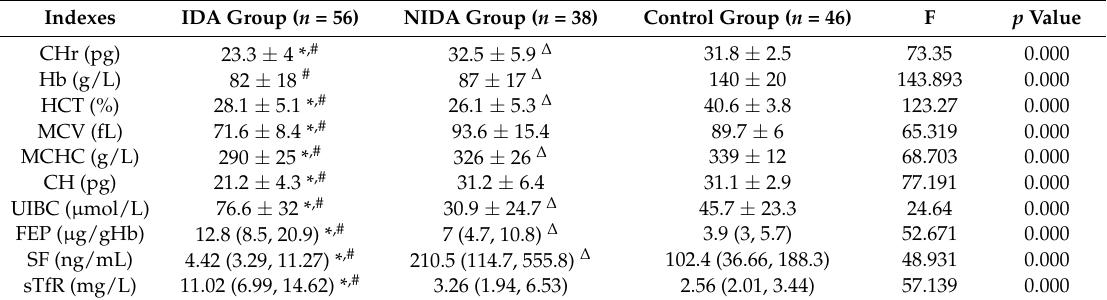
Table 2. Comparison of hematologic and biochemical indexes for the different diagnostic